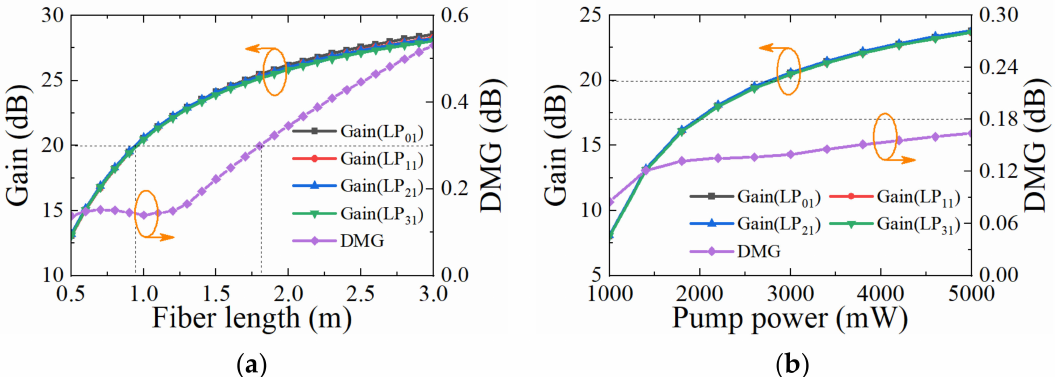
Figure 6. Gains and DMG versus ( a ) fiber length (under 3000 mW pump power) and ( b ) pump power (under 1 m length of